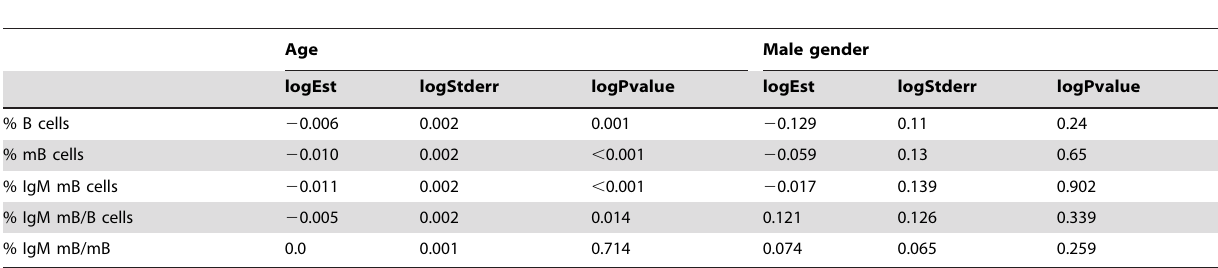
Table 2. Effects of age and gender on B cell subsets after splenectomy in mixed model